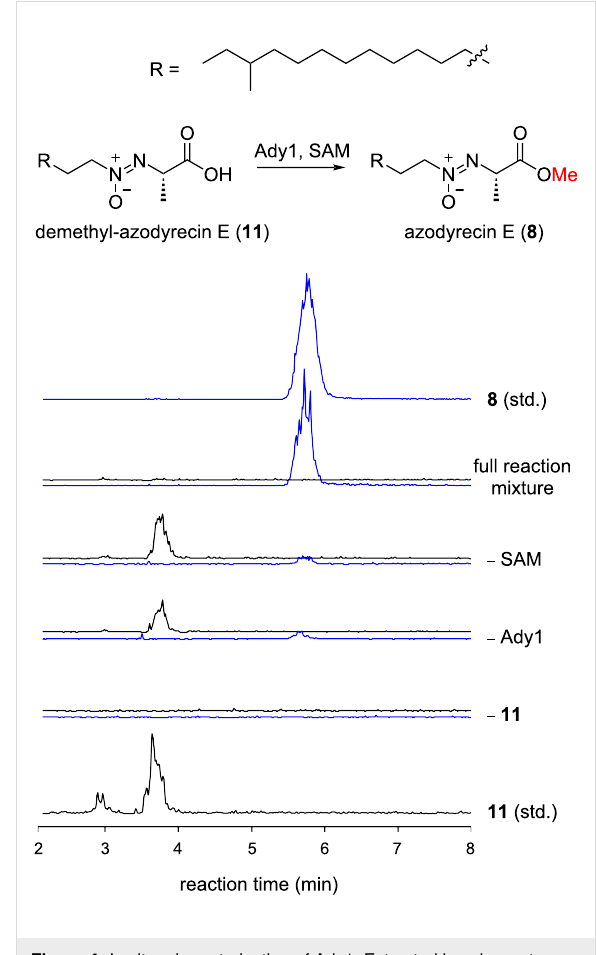
Figure 4: In vitro characterization of Ady1. Extracted ion chromato- grams at m/z 329.3 (black) and m/z 343.3 (blue), corresponding to compound 11 and 8 , respectively, are